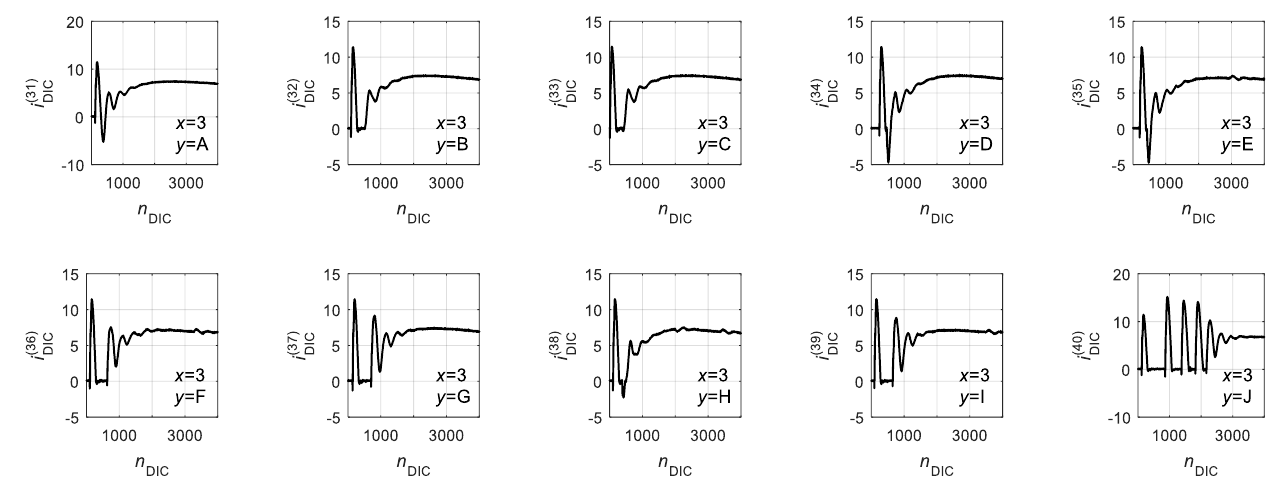
Figure 22. Current vectors